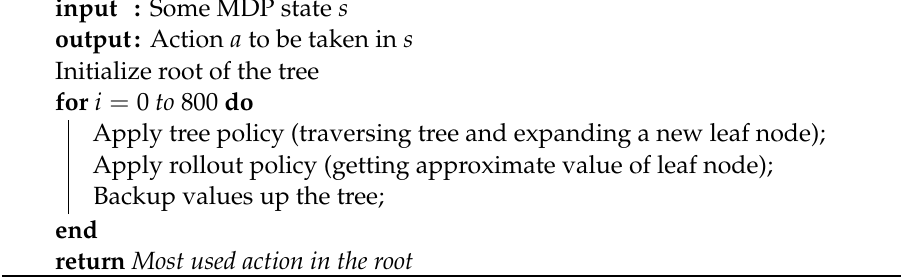
Algorithm 1: General MCTS